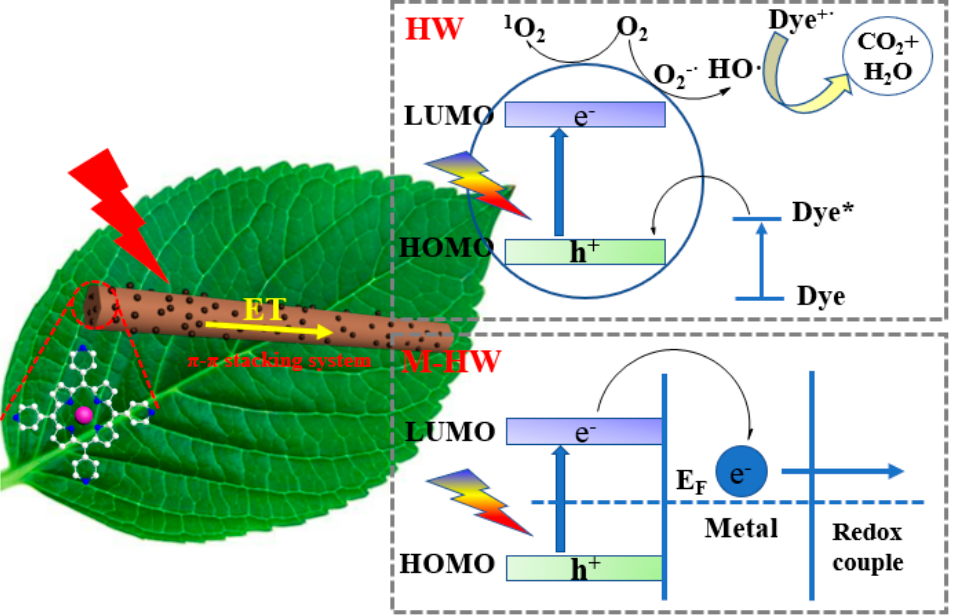
Figure 8. The charge-transfer process and mechanism of enhancing the photocatalytic performance.